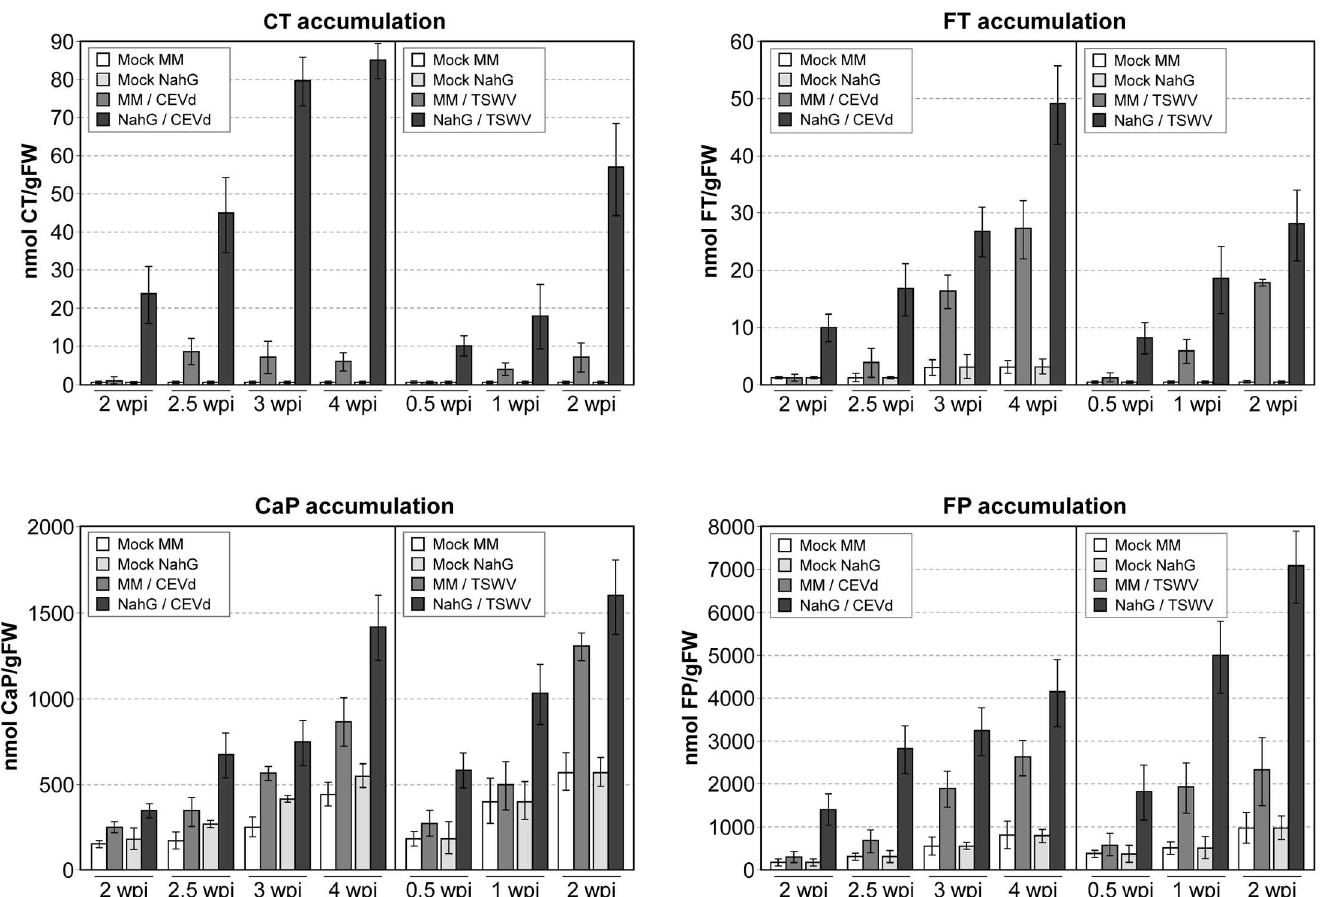
Fig 9. Effect of Citrus Exocortis Viroid (CEVd) and Tomato Spotted Wilt Virus (TSWV) infections on levels of p-coumaroyltyramine (CT), feruloyltyramine (FT), caffeoylputrescine (CaP), and feruloylputrescine (FP) in Money Maker and NahG tomato leaves. Plants were inoculated with either CEVd or TSWV and samples were collected at the indicatedtimes (weeks post-inoculation,wpi) for both infected and mock-inoculated leaves, and then analyzedby HPLC/ESI-MS. Data correspond to the mean ± SD of three biologicalreplicates of one representative experiment. The experiments were repeatedat least 3